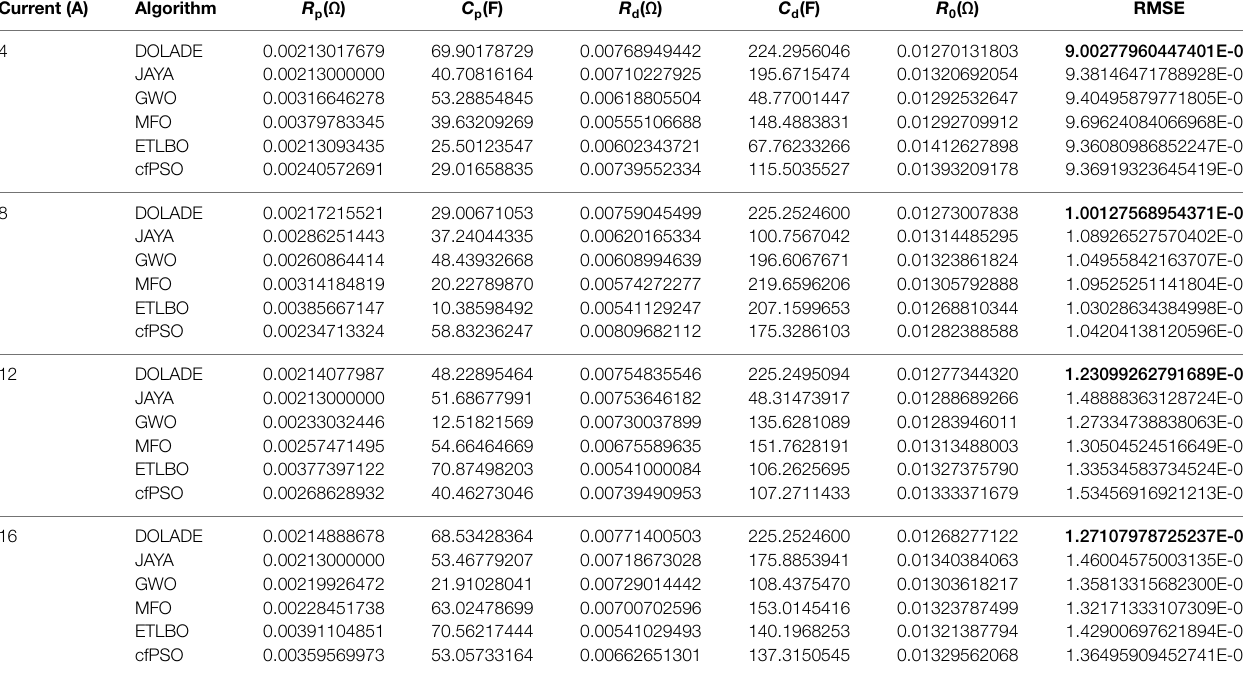
TABLE 4 | Comparison among six algorithms on the SECM under different currents.